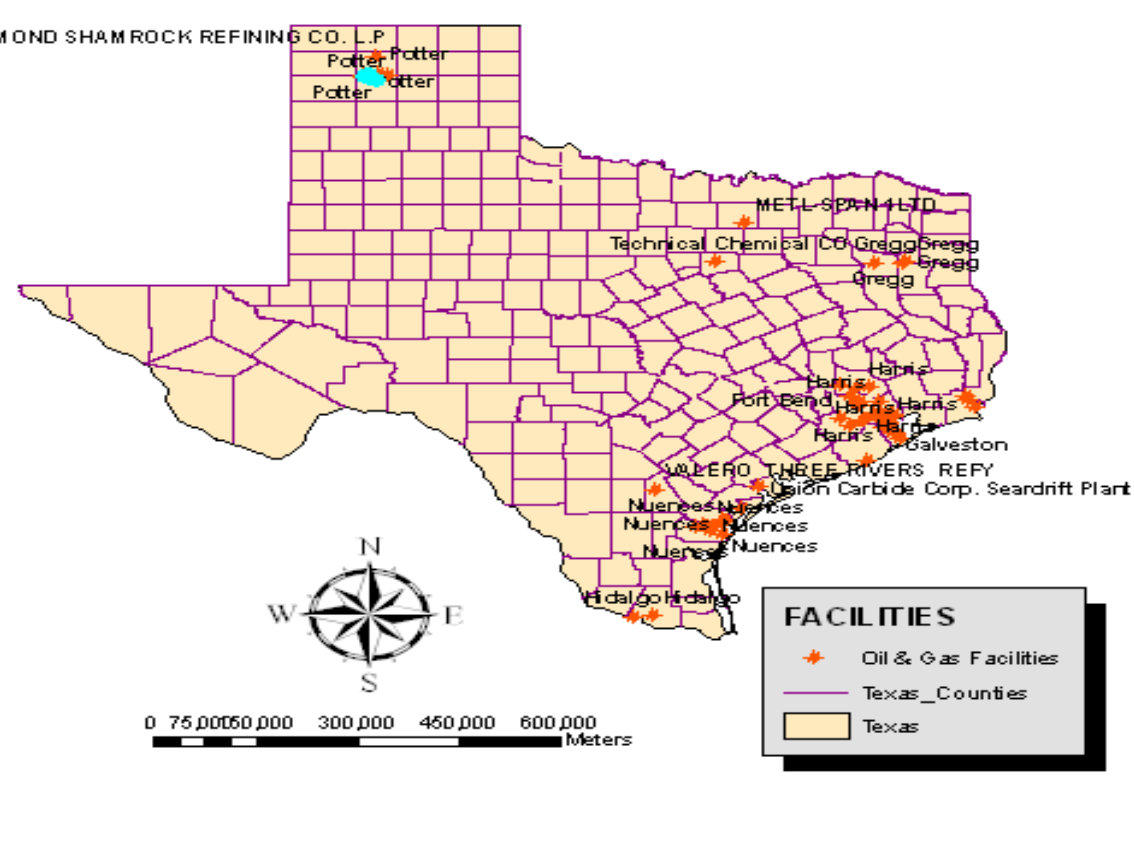
Figure 3. The Spatial Distribution of Pipeline Infrastructure, Source: Carillo, V. (2006)